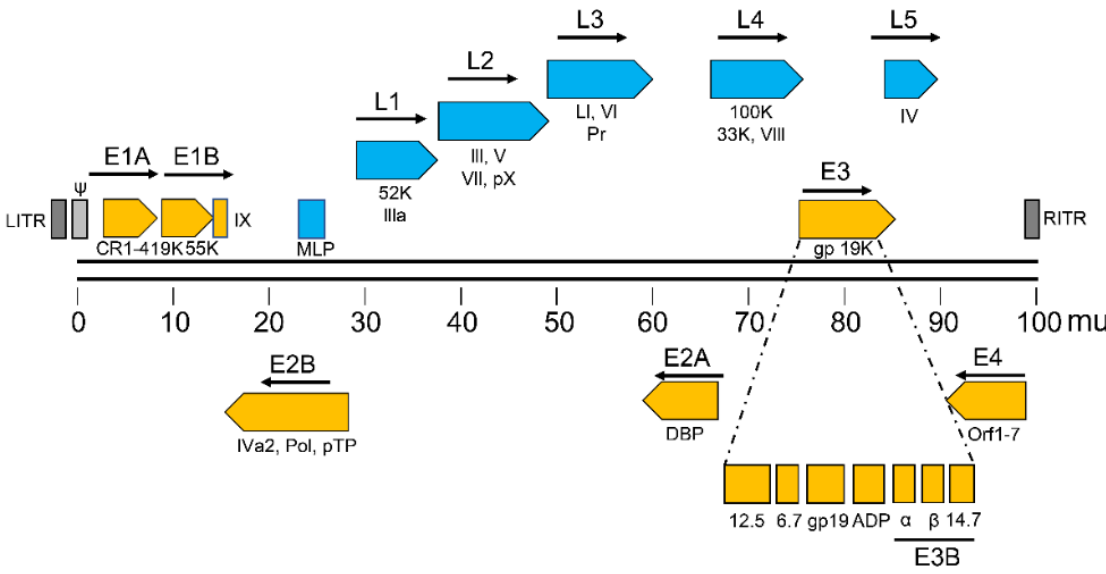
Figure 1. Schematic representation of the serotype 5 adenoviral genome. DNA strands are shown as a pair of lines. The number below the lines indicates the 0–100 map unit (mu) of the adenoviral genome.